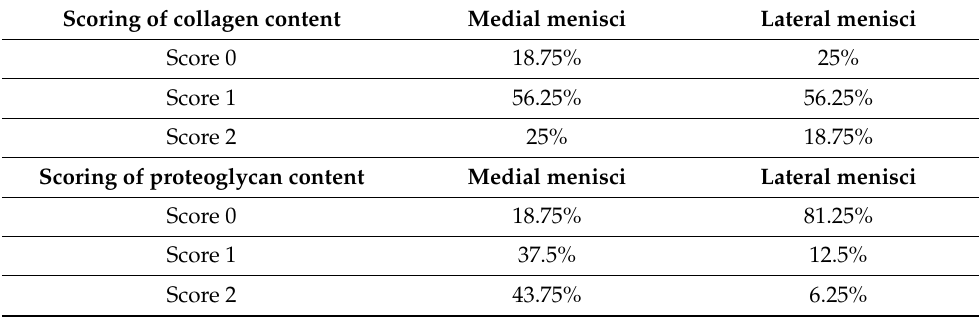
Table 4. Percentage distribution of scoring of collagen content in medial and lateral